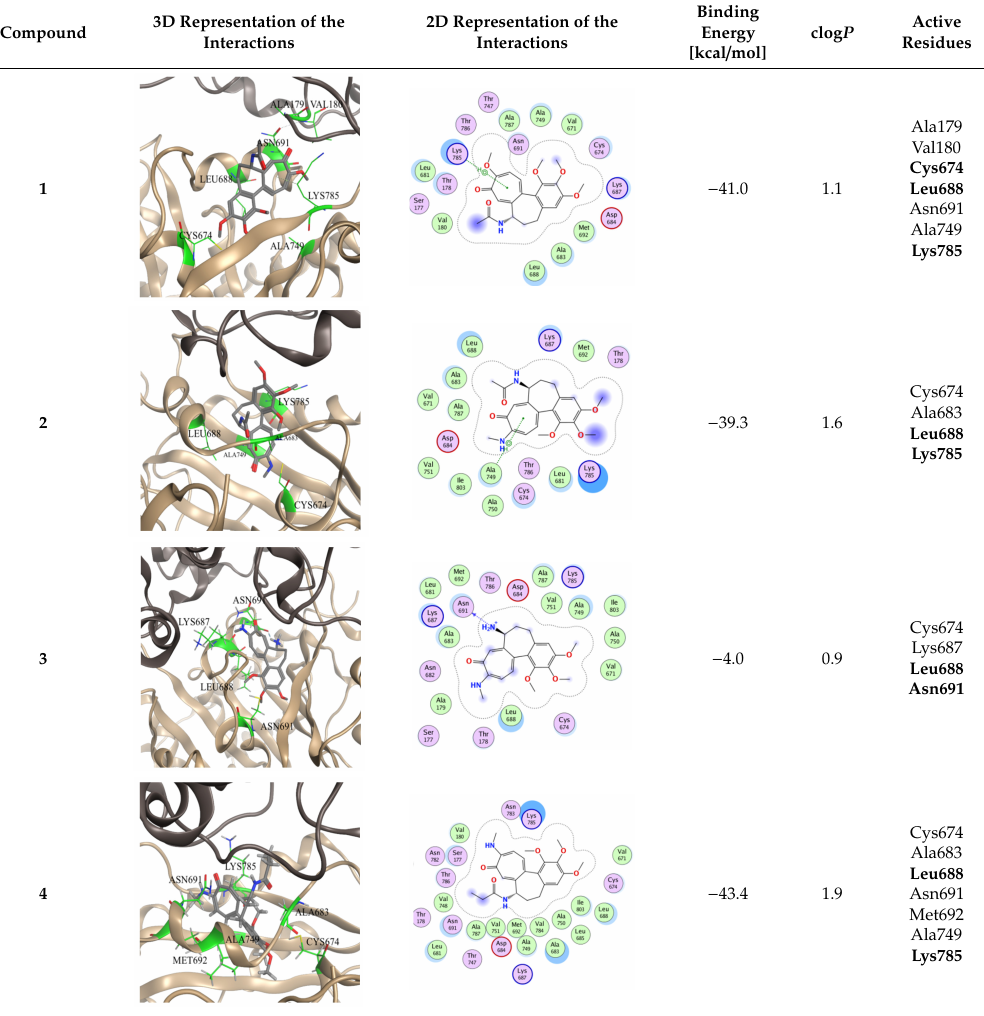
Table 3. Computational predictions of interactions between tested compounds ( 1 – 21 ) and